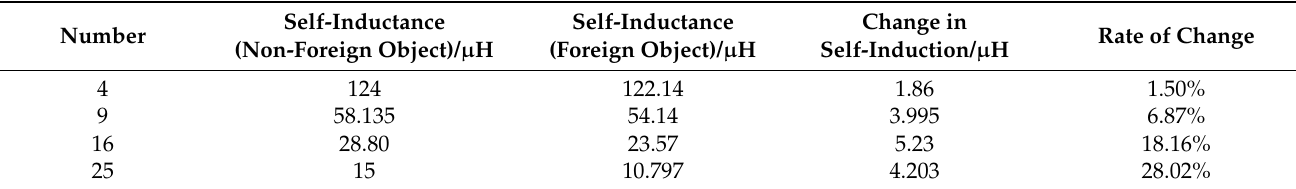
Table 2. The change of self-inductance under different number of detection